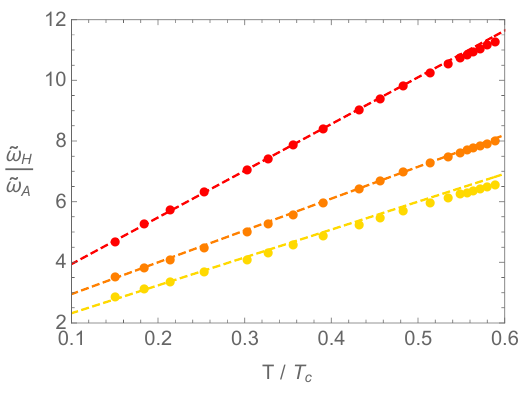
Figure 18 . The ratio ˜ ω H / ˜ ω A as a function of the reduced temperature for λ/T = (0 . 1 , 0 . 2 , 0 . 3) (red, orange, yellow). The dashed line are the fitting to the function: ζ